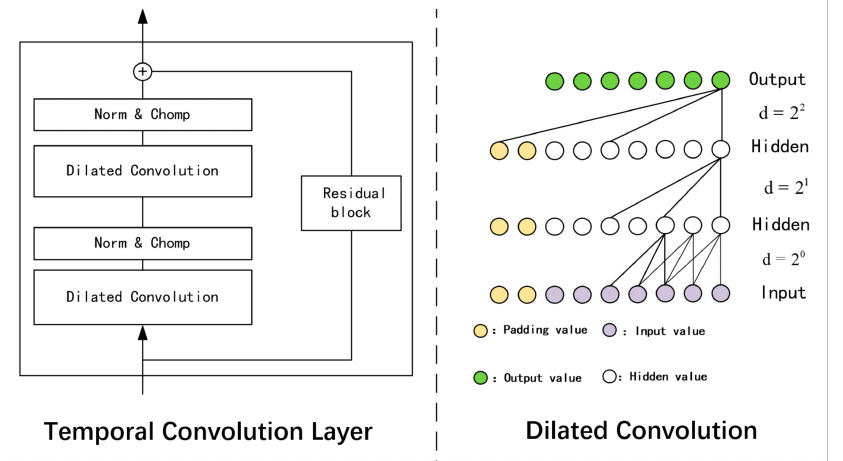
Figure 1. A Temporal Convolution Layer ( left ) and Dilated Convolution operation ( right ). The first convolution projects the input into a hidden dimension with the second convolution projected into output dimension. In each layer, a convolution of the size of 1 is used as a residual connection. The chomp operation is used to chomp the padding value that may come out with output and keep dimensions consistent.